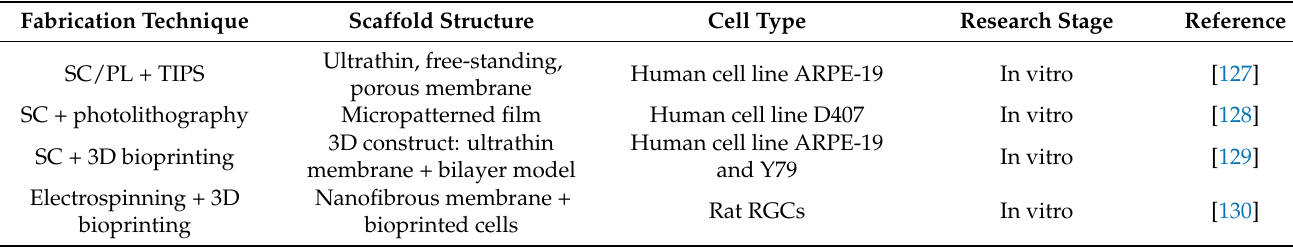
Table 5. A summary of hybrid approaches used in retinal applications. This table highlights the fabrication technique, the structure of the scaffold and the cell type used. RGC: retinal ganglion cells. Fabrication Technique Scaffold Structure Cell